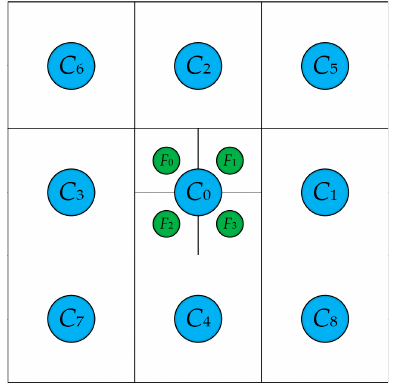
Figure 8. Schematic diagram of the coarse and fine grids in 2D.